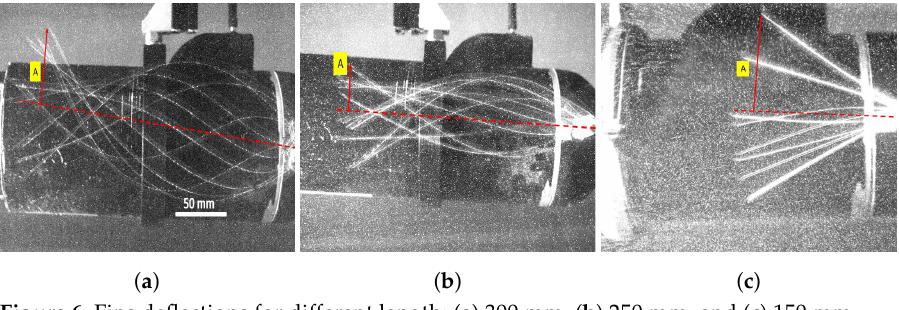
Figure 6. Fins deflections for different length: ( a ) 300 mm, ( b ) 250 mm, and ( c ) 150